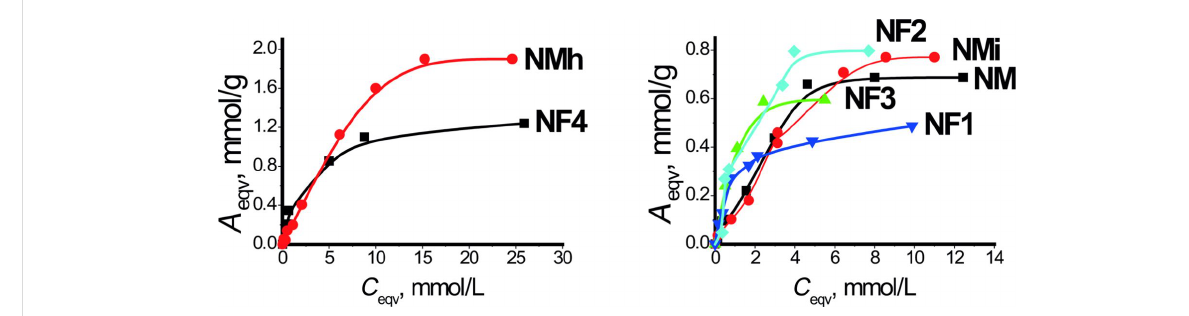
Figure 5: Copper(II) ion adsorption isotherms at 28 °C.